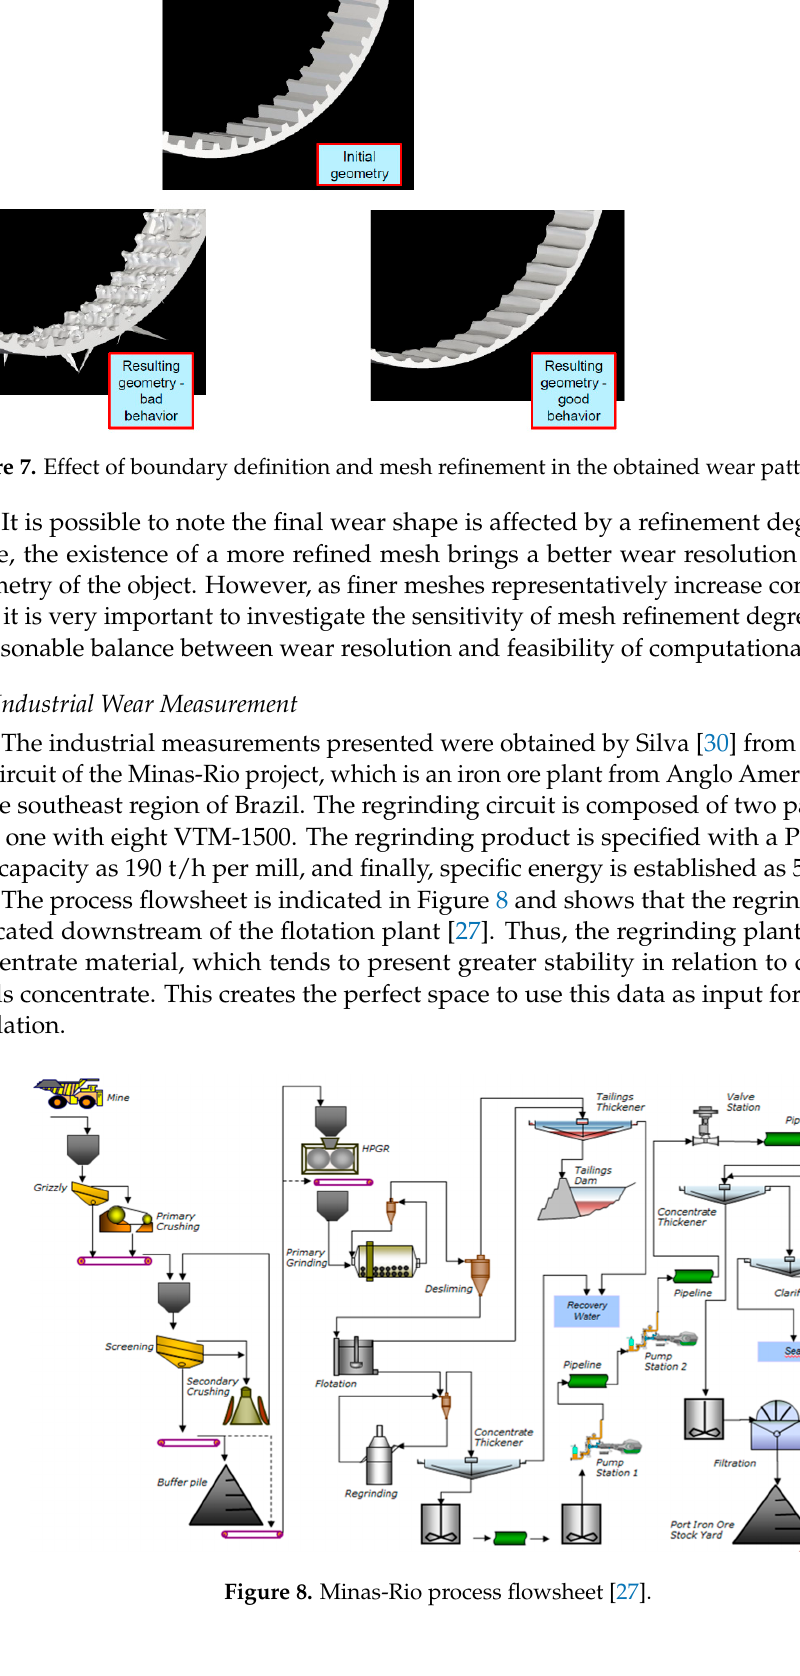
Figure 8. Minas-Rio process flowsheet [27].